Question: From the figure, is the trend upward or downward?
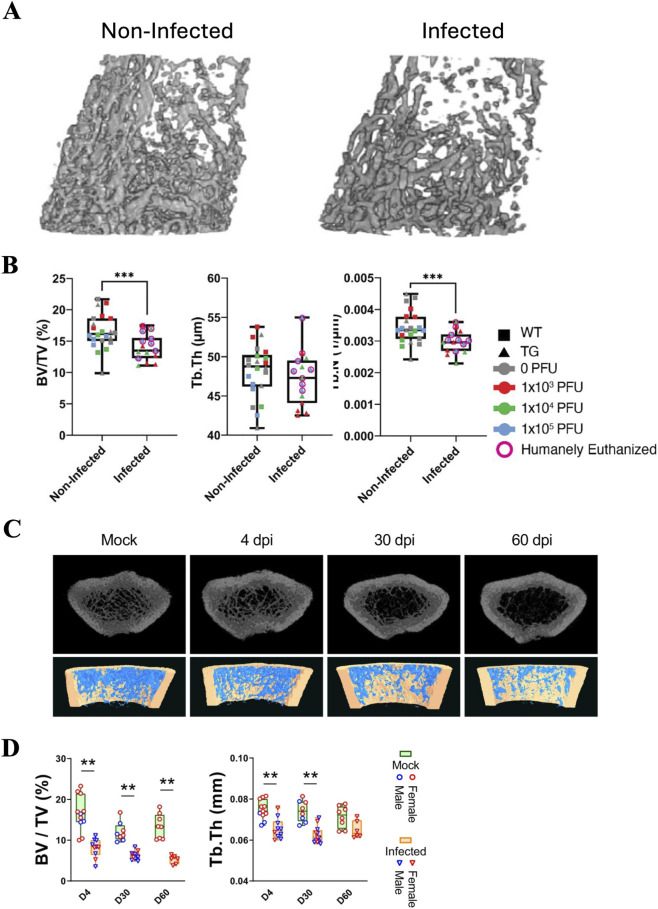
Answer: decreasing